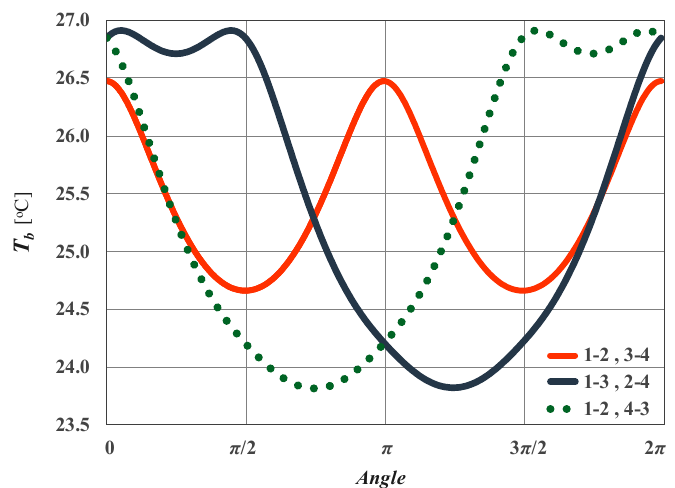
Figure 6. Angular temperature distribution along the perimeter of the borehole.